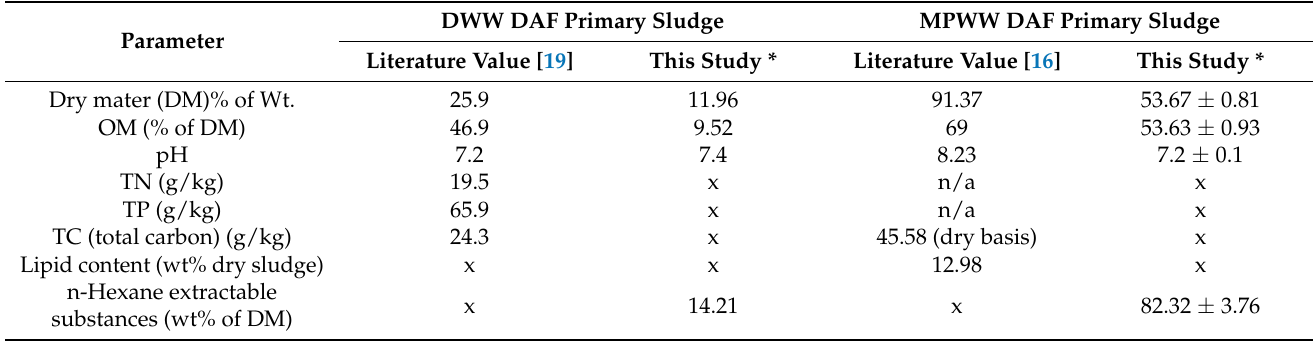
Table 2. Comparison of DWW and MPWW DAF sludge chemical content.